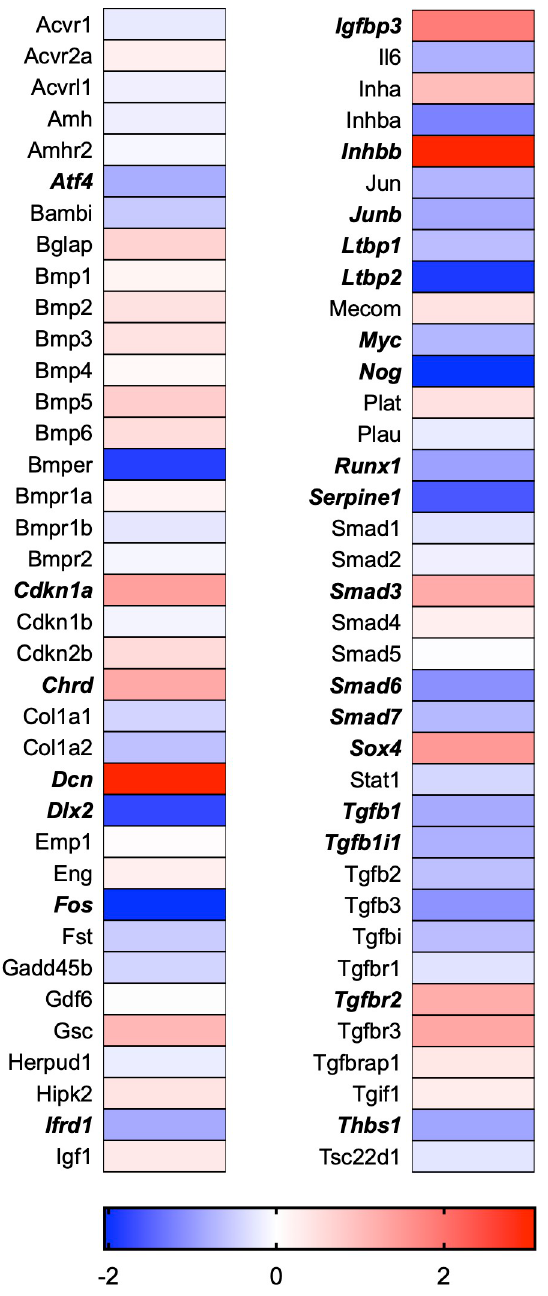
Fig 7. TGF- β signaling heat map. Bold text indicates significantly altered gene